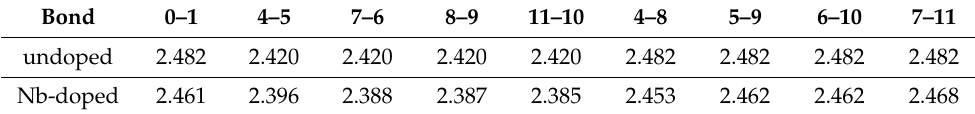
Table 4. Change of bond length between adjacent iron atoms of niobium before and after doping ( A ).